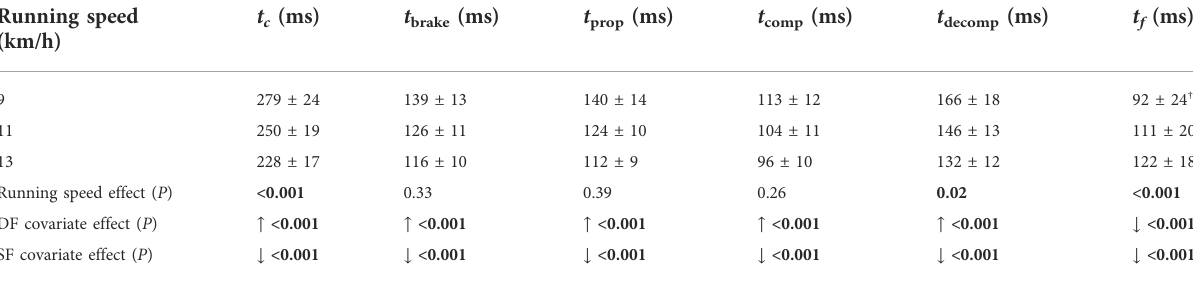
TABLE2Temporalvariablesforrunnersatendurancerunningspeeds.Signi fi cantdifferences( P ≤ 0.05)identi fi edbylinearmixedeffectsmodelingare indicated inbold.Note:valuesarepresentedas mean±standarddeviation.DF:dutyfactor, SF:step frequency, t c :contacttime, t brake :brake time, t prop :propulsiontime, t comp :compressiontime, t decomp :decompression time, and t f : fl ight time.SF covariate was normalized by gravitational constant and L 0 the leg length. Up ( ↑ ) and down ( ↓ ) arrows indicate positive and negative effects of the covariate, respectively. † and ‡ Signi fi cantly different from the value at 13